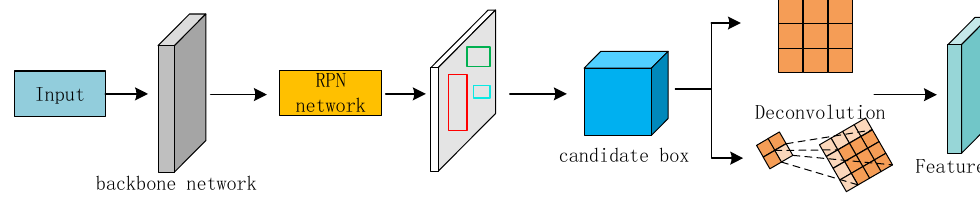
Figure 5. CAROI pooling principle.